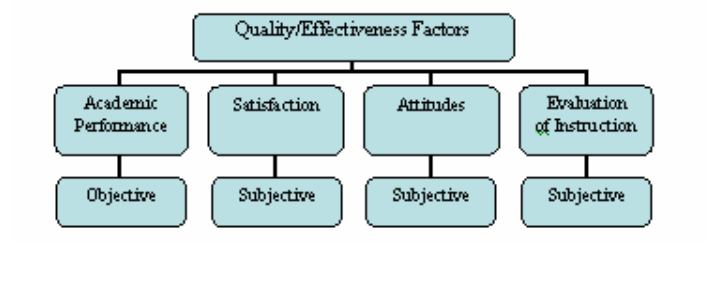
Figure 1. Quality / Effectiveness